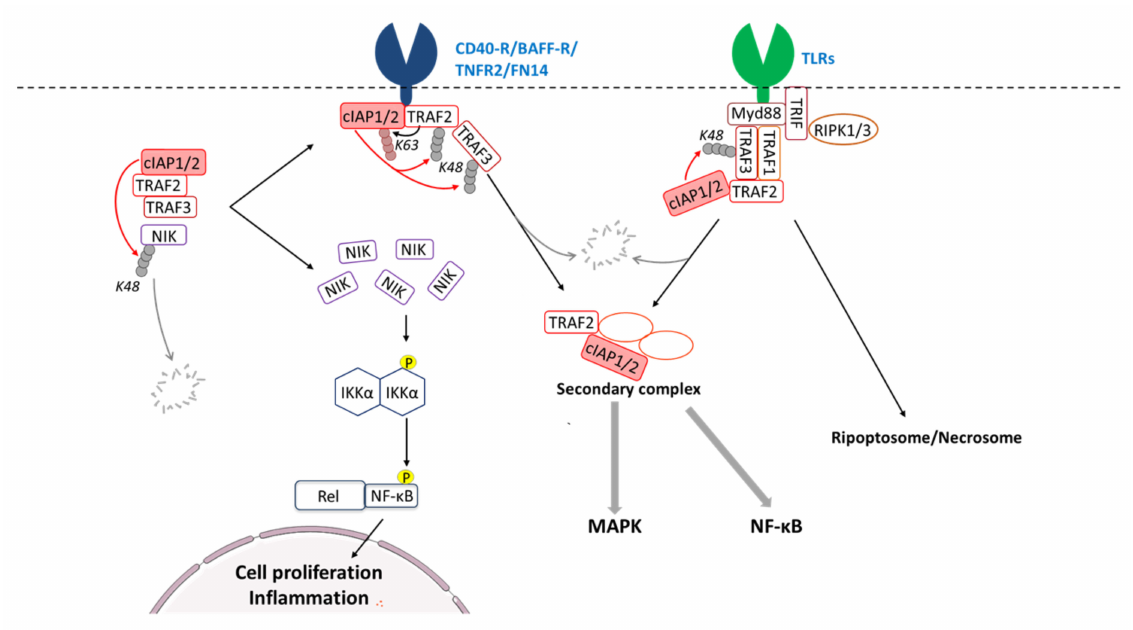
Figure 3. Regulation of signaling pathways by cIAP-mediated degradation of TRAF2 and / or TRAF3. In standing state, the cIAPs / TRAF2 / 3 E3-ubiquitin ligase complex controls the cellular content NIK (NF- κ B-inducing kinase) by mediating K43-linked ubiquitination and proteasomal degradation. Stimulation of CD40-R (cluster of di ff erentiation 40 receptor), BAFF-R (B-cell activating factor receptor), TNFR2 (tumor necrosis factor Receptor 2), FN14 (Fibroblast growth factor-inducible 14), or TLRs (toll-like receptors) promotes the recruitment of cIAPs / TRAFs complex to the receptor leading to the accumulation of NIK, phosphorylation of IKK α dimer, and activation of the non-canonical NF- κ B pathway. In receptor-associated complex, TRAF2 can stimulate cIAPs via K63-linked ubiquitination. In turn, cIAPs catalyse the K48-linked polyubiquitination of TRAF3 and, in a lower level, TRAF2, causing their degradation and the formation of a secondary complex. Upon TLR stimulation, RIPK1 / 3 (receptor-interacting kinase 1 / 3) are also recruited to the receptor complex that can lead to the assembly of Ripoptosome and / or necrosome. Myd88: Myeloid di ff erentiation primary response 88;